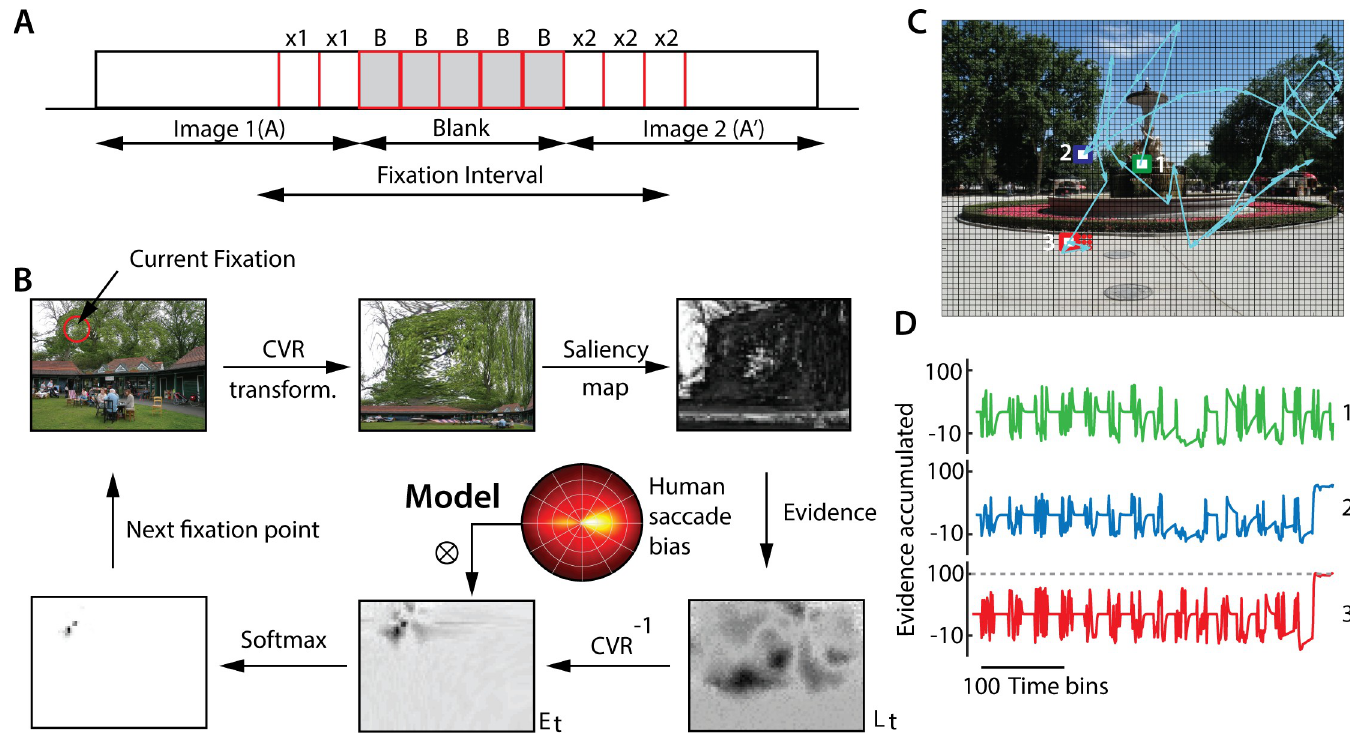
Fig 4. A Bayesian model of gaze strategies for change detection. A. Schematic showing a typical fixation across the pair of images (A, A’) and an intervening blank. B. Detailed steps for modeling change detection (see text for details). (Clockwise from top left) At each fixation, a Cartesian variable resolution (CVR) transform is applied to mimic foveal magnification, followed by a saliency map computation to determine firing rates at each location. Instantaneous evidence for change versus no change (log-likelihood ratio, log L(t)) is computed across all regions of the image. An inverse CVR transform is applied to project the evidence back into the original image space, where noisy evidence is accumulated, (sequential probability ratio test, drift-diffusion model). The next fixation point is chosen using a softmax function applied over the accumulated evidence (E t ). To model human saccadic biases, a distribution of saccade amplitudes and turn angles is imposed on the evidence values prior to selecting the next fixation location (polar plot inset). C. A representative gaze scan path following model simulation (cyan arrows). Colored squares: specific points of fixation (see panel D). Grid: Fine divisions over which the image was sub-divided to facilitate evidence computation. Green (1), blue (2) and red (3) squares denote first (beginning of simulation), intermediate (during simulation) and last (change detection) fixation points, respectively. D. Evidence accumulated as a function of time for the same three representative regions as in panel D; each color and number denotes evidence at the corresponding square in panel C. When the model fixated on the green or blue squares (in panel C), the accumulated evidence did not cross the threshold for change detection. As a result, the model continued to scan the image. When the model fixated on the red square (in the change region), the accumulated evidence crossed threshold (horizontal, dashed gray line) and the change was detected.